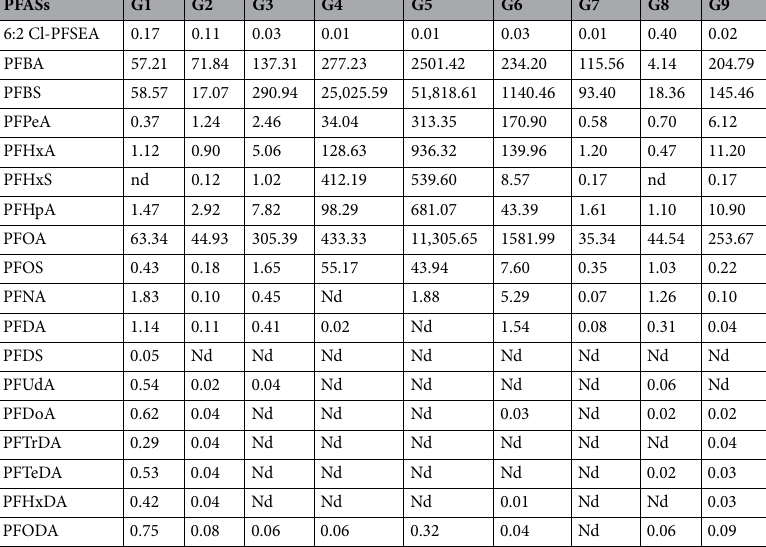
(Fig. 1 and Table 2). Short chain PFASs, as alternatives to long chain substrates, have been widely used in the FCP of Fuxin City or in other countries 21 . The PFASs contamination in our study area was much higher than those in other regions, including Taiwan 30 , the Maozhou River basin 28 , a Tianjin suburb 31 and Hubei Province 32 . Short chain PFASs (PFBA, PFBS, PFHpA, PFHxA and PFHxS) and PFOA are commonly detected currently due to the heavy use of long chain substitutes and different industry types 17,32 . There is no current environmental standard for PFASs in China, whereas newly emerging pollutants have been of concern in Canada 33 , Swedish 13 , American 34 and so on. The U.S. Environmental Protection Agency (USEPA) limit for PFOA in drinking water is 400 ng·L −1 , and the PFOA concentration (35.34–11,305.65 ng·L −1 ) exceeds the standard value by several orders of magnitude 35 . The low concentration detected for long-chain PFASs (C ≥ 8) may result mainly from historical industry production and emissions. Short chain PFASs applied to improve hydrophilicity and fluidity tend to migrate easily in water bodies, whereas long chain PFASs are readily adsorbed by large particles or sediments 36 . The Xi River is the main river flowing through the FCP and receives many industrial pollutants throughout the year. Surface water recharge and infiltration moves PFASs into the groundwater system. Based on contamination in the Maozhou River basin, a potential link between the surface and groundwater was identified, and the PFASs concentration in surface water had a highly positive relationship with that in groundwater 37 . A PFOS substitute of 6:2 Cl-PFSEA was detected at low concentrations (0.01–0.17 ng·L −1 ), which indicates that the emerging PFASs substitute has been used in local industrial production 38,39 (Table 2). In addition, PFSAs concentrations were much higher than PFCAs concentrations. Different functional groups cause PFASs to exhibit varied environ- mental behaviour, especially short chain PFASs, which migrate easily in water bodies 40 . Correlation relationship analysis. Correlations among various pollutants and physicochemical proper- ties (see Supplementary Table S6 online) are shown in Fig. 2. The relationship between F − concentration and physicochemical properties was weak in groundwater except for DO, and the result was the same as that of Loganathan et al. for soil 41 . The F − concentration had a strongly negative relationship (R 2 = − 0.717, p = 0.02) with DO, which indicates that DO content may influence F − migration or behaviour, but this also needs to be studied further. In the present study, the weak correlation between F − and heavy metals was due to frequent rain, which dilutes the pollutants in water. The F − in groundwater has many sources, including atmospheric deposition, agri- cultural activities, geographical factors, fertilizers and pesticides 42 . Although the F − concentration had no sig- nificant relationship with TH (R 2 = − 0.337, p = 0.3) in groundwater, F − concentrations are continuously enriched, even after the groundwater reaches equilibrium with respect to CaF 2 levels, due to removal of Ca by precipitation of calcite (CaCO 3 ) 42,43 . In addition, plant cover type and amount, rain and soil properties also affect the migra- tion of F − from the surface to groundwater 40 . The F − concentration showed the only significant relationship with heavy metal levels ( p < 0.1) in soils from Shifang County of Sichuan Province; similarly, this relationship and the solubility of F − in groundwater needs to be further studied 44 . The environmental behaviour of PFASs in water bodies is influenced by various physicochemical properties, but the correlations between PFASs and physicochemical properties were limited in this study. pH, DO, RP, SC, TH, TDS and TC showed no significant positive or negative relationships with individual PFAS concen- trations, whereas the water level had a positive correlation with short-chain PFASs and a negative correlation with long-chain PFASs. PFBA (R 2 = 0.703, p = 0.03), PFBS (R 2 = 0.803, p = 0.009), PFPeA (R 2 = 0.619, p = 0.052), PFHxA (R 2 = 0.710, p = 0.03), PFHxS (R 2 = 0.802, p = 0.001), and PFHpA (R 2 = 0.620, p = 0.054) had positive rela- tionships with water level. PFASs tend to migrate to deep groundwater and soil along the path for movement